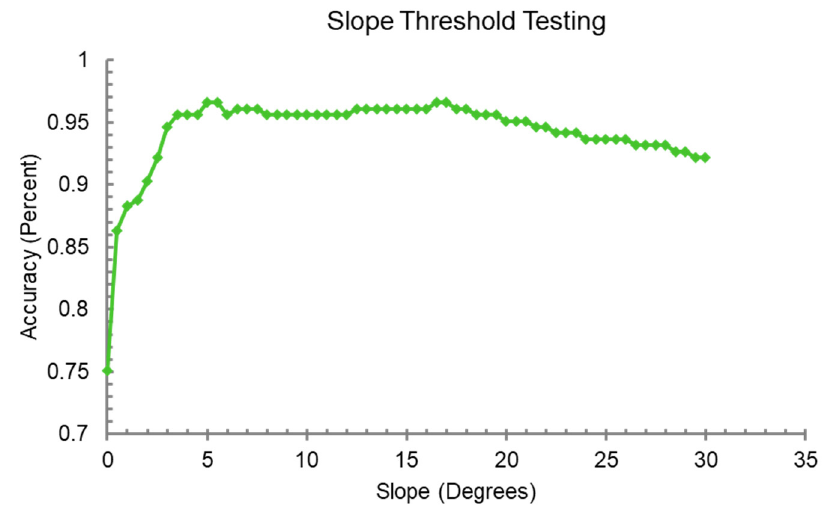
Figure 5. Slope calculated from a Digital Elevation Model (DEM) was applied to the mountainous granule T11UQQ. Pixels marked as water but with steep slopes were removed. This graph shows accuracy goes from 76% without a DEM, to as high as 96% with a slope degree threshold of about 17 degrees.